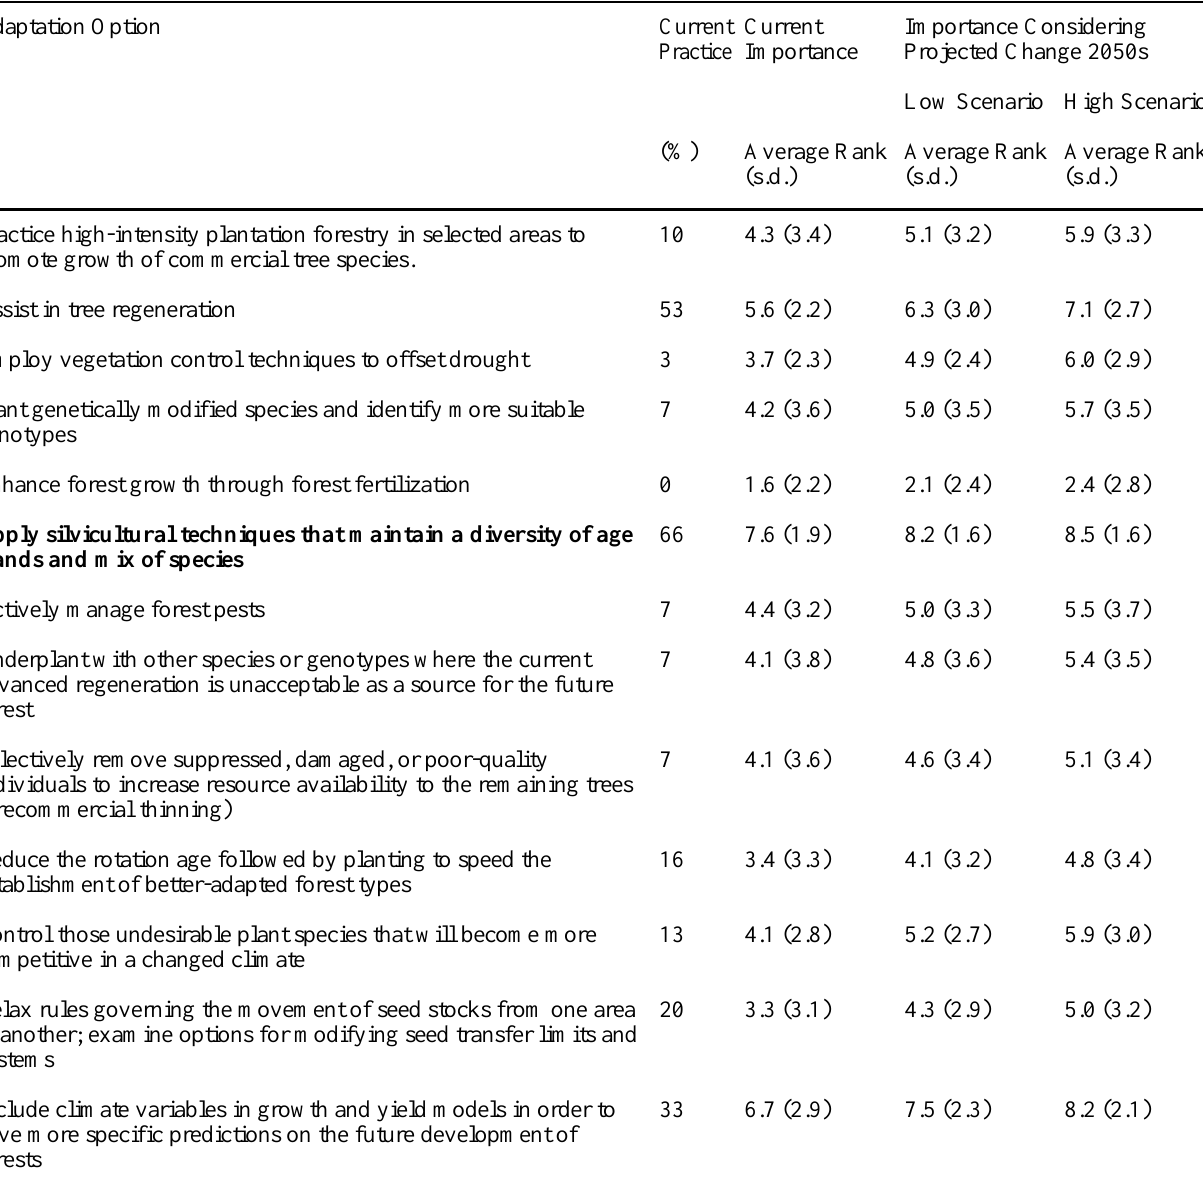
Table 5. Judgments of forest practitioners on the importance of adaptation options to maintain the productive capacity of forest ecosystems in the Champagne and Aishihik Traditional Territory for each of three scenarios: “current climate conditions,” “low scenario of future climate change by the 2050s,” and “high scenario of future climate change by the 2050s.” Scale of 1 to 10 (0 = no importance, 1 = low importance, 10 = high importance) or don’t know. Results shown are the average rank and standard deviation (s.d.) of participants who provided a ranking. The percentage of participants who agree or strongly agree with the statement “this management option is currently being practiced in the Yukon” is also provided. Adaptation options in bold are considered to be “no-regrets” (option is ranked 7 or higher across range of